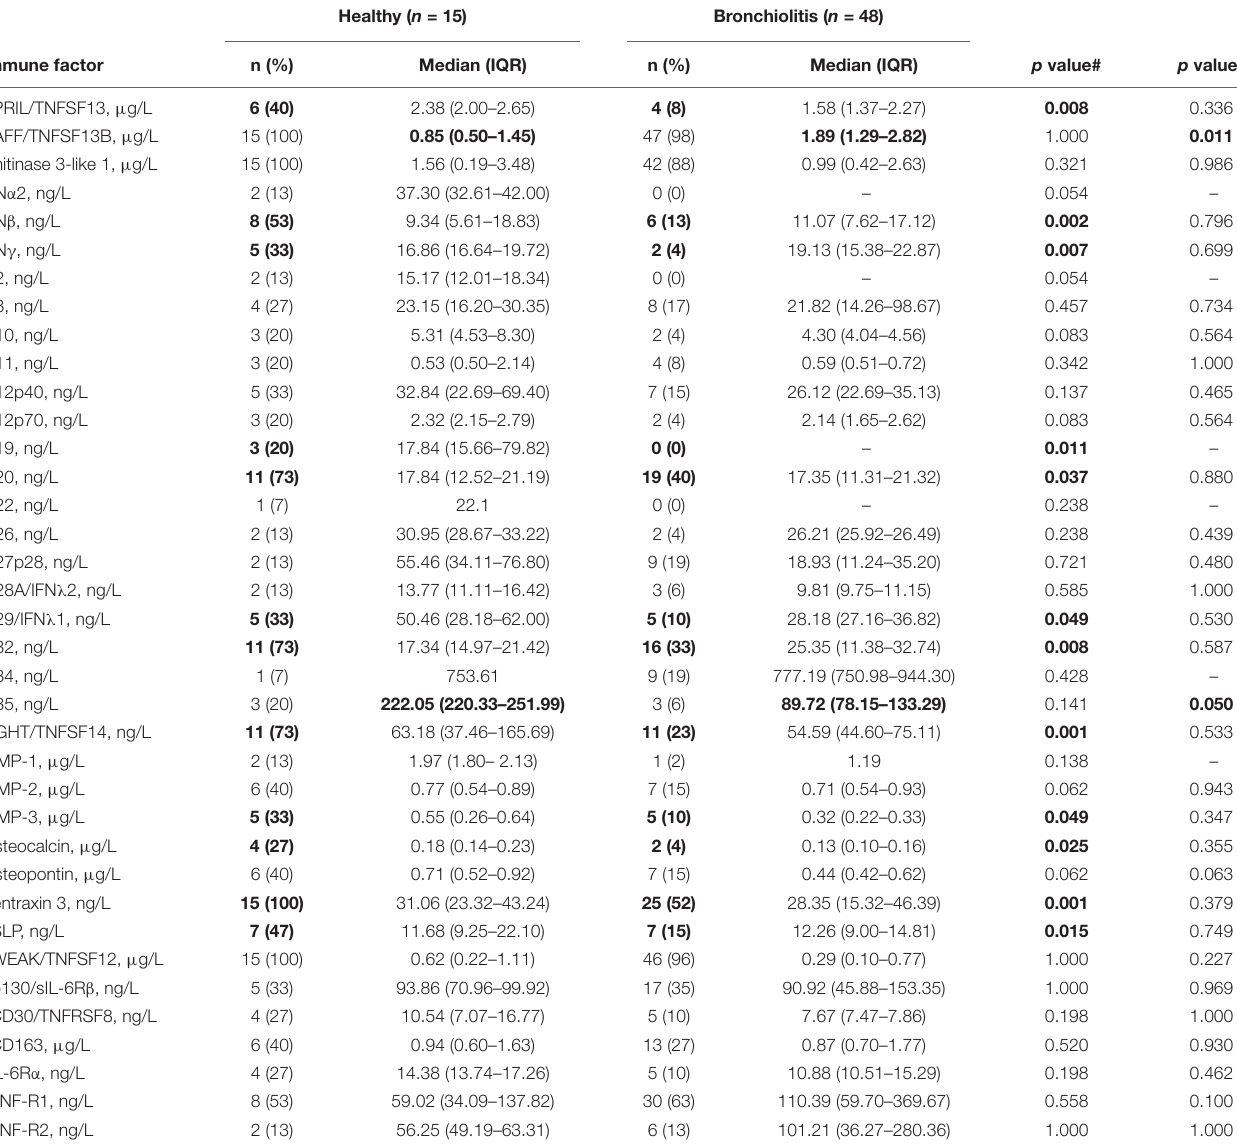
TABLE 5 | Prevalence (%) and concentration of immune factors in fecal samples from healthy control and bronchiolitis groups. Healthy ( n = 15) Bronchiolitis ( n =